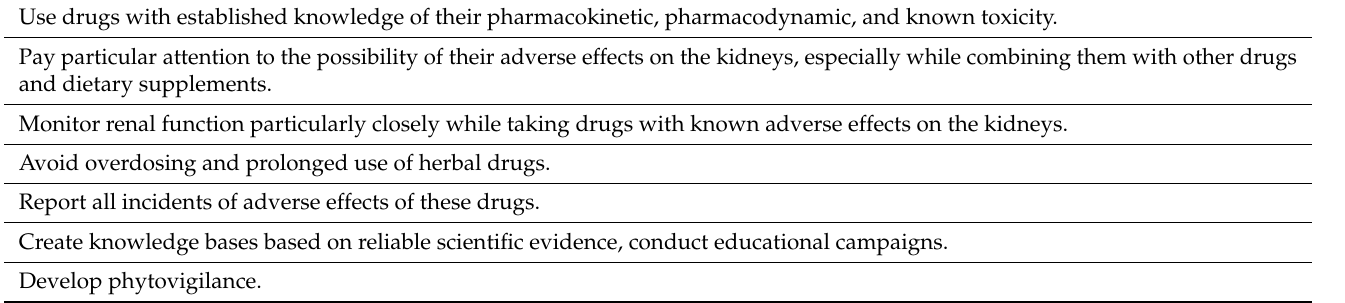
Table 5. How can the risk of nephrotoxicity of plant-derived drugs be